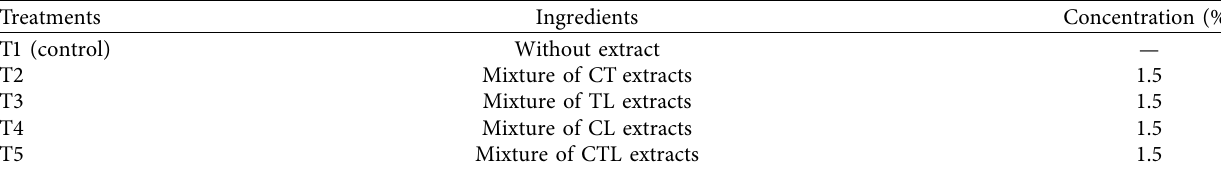
Table 1: Composition of the five different experimental treatments used. Treatments